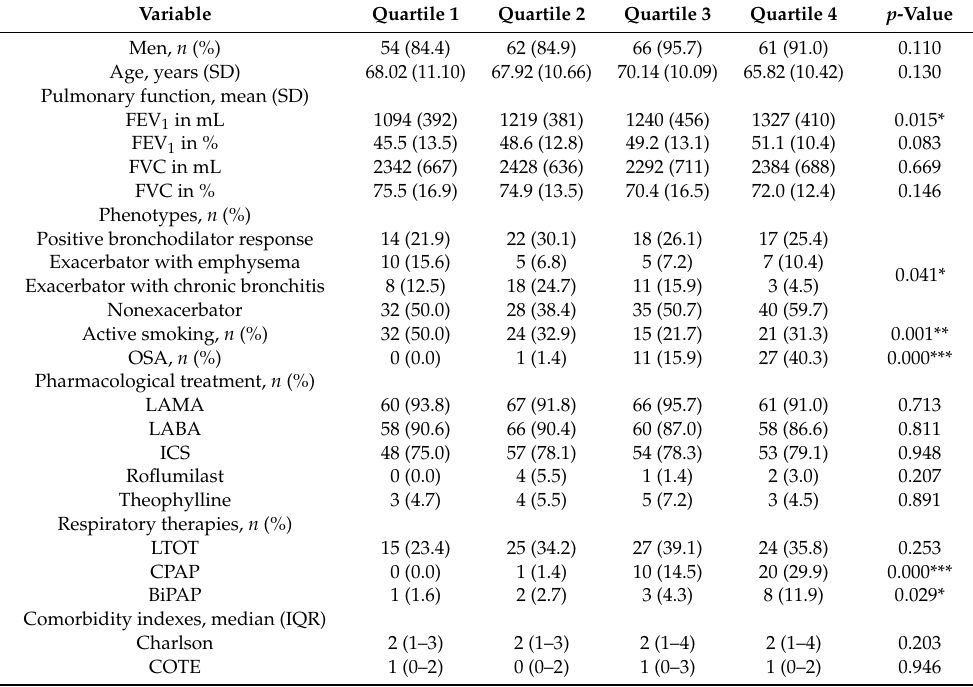
Table 3. Anthropometric data, lung function, phenotype, treatment, and comorbidity indexes according to BMI